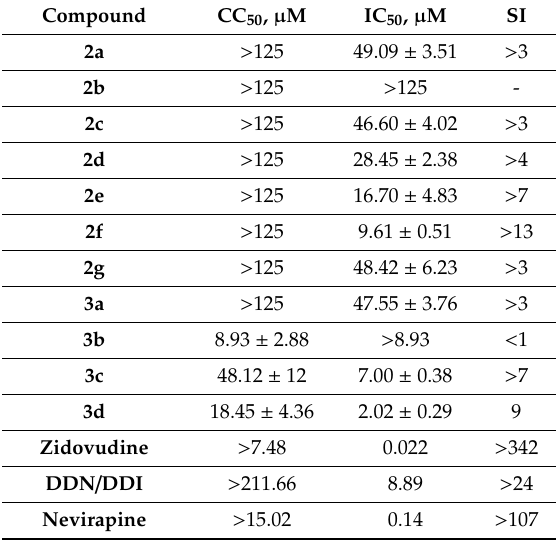
Table 1. Cytotoxicity and antiviral activity against HIV (strain III B , SEM cells). Compound